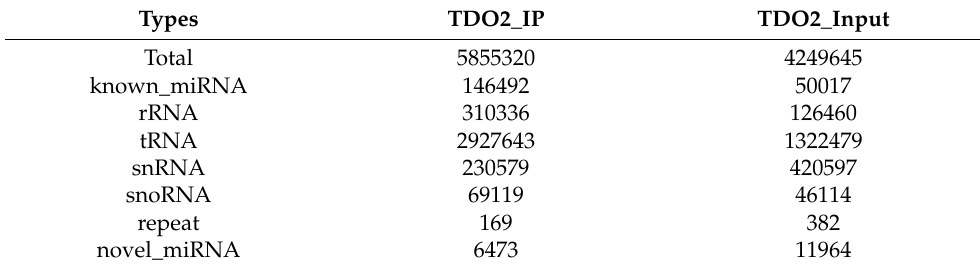
Table 1. Comparison of the sRNA classification statistical table.